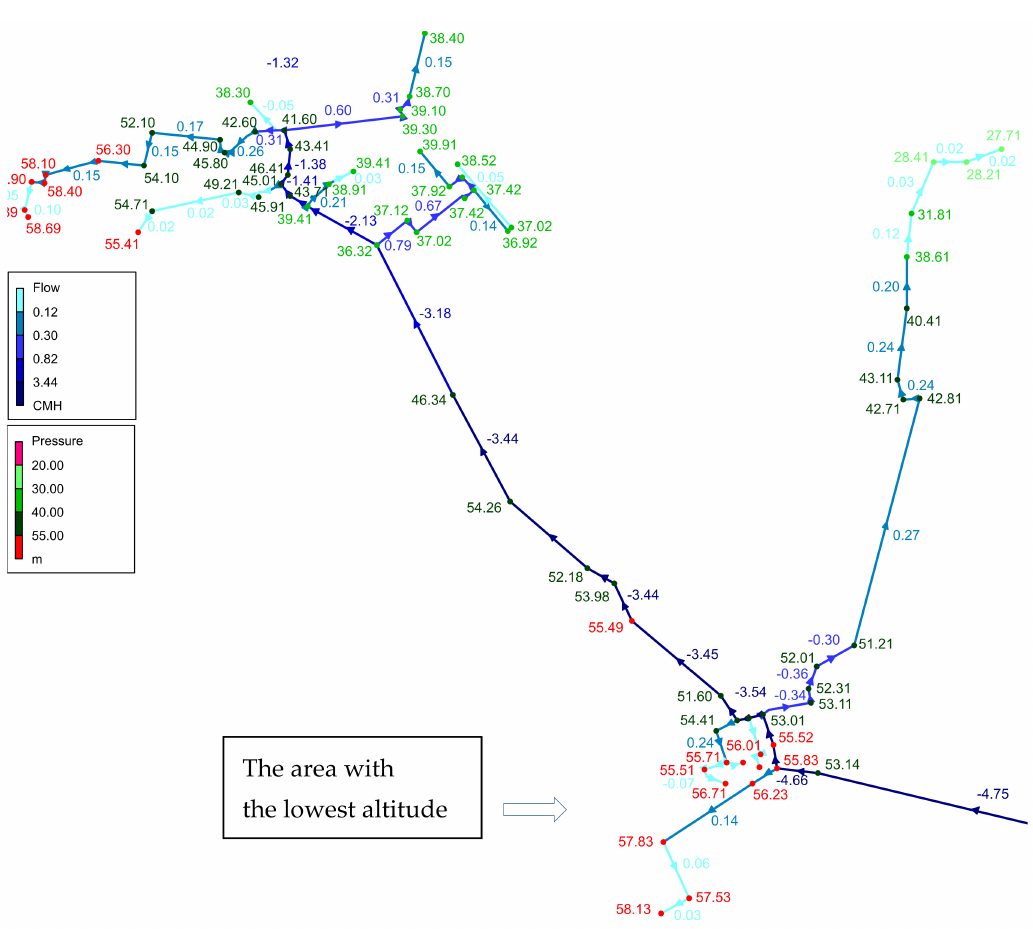
Figure 6. The pressure and flow rate for the average hourly water demand; zoomed view of the map on the north-western part of the